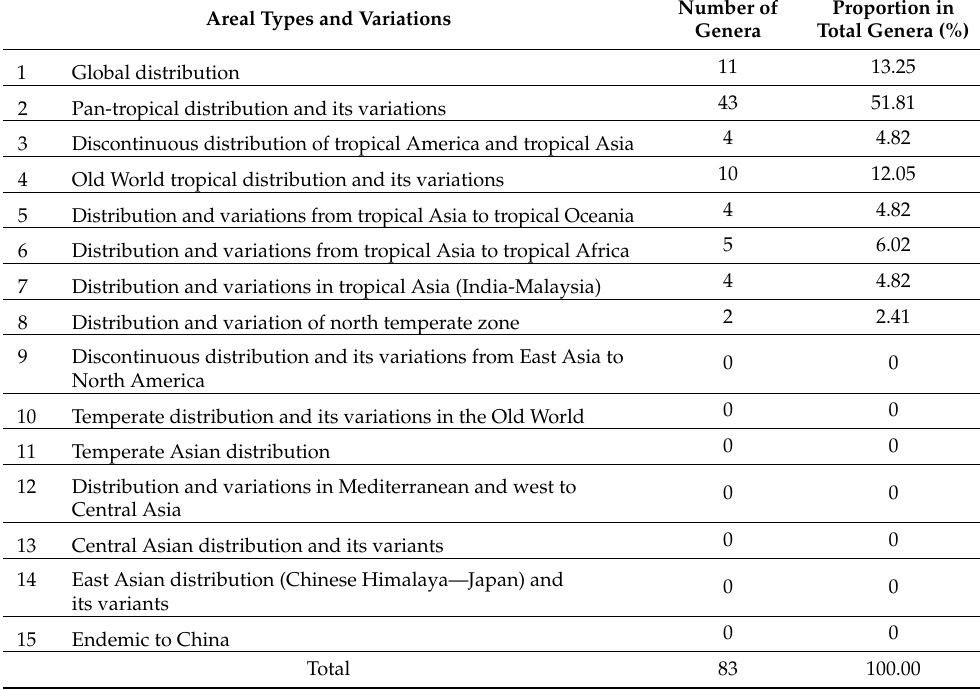
Table 2. Floristic statistics of main seed plants in current habitats in the project